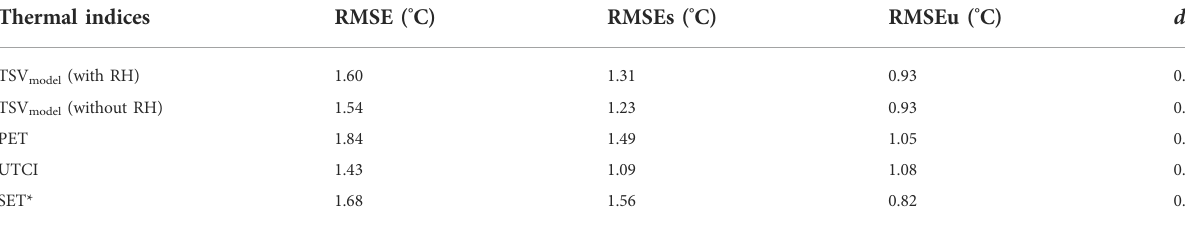
TABLE 8 Quantitative measures of thermal indices ’ assessment scales performance with observed data. Thermal